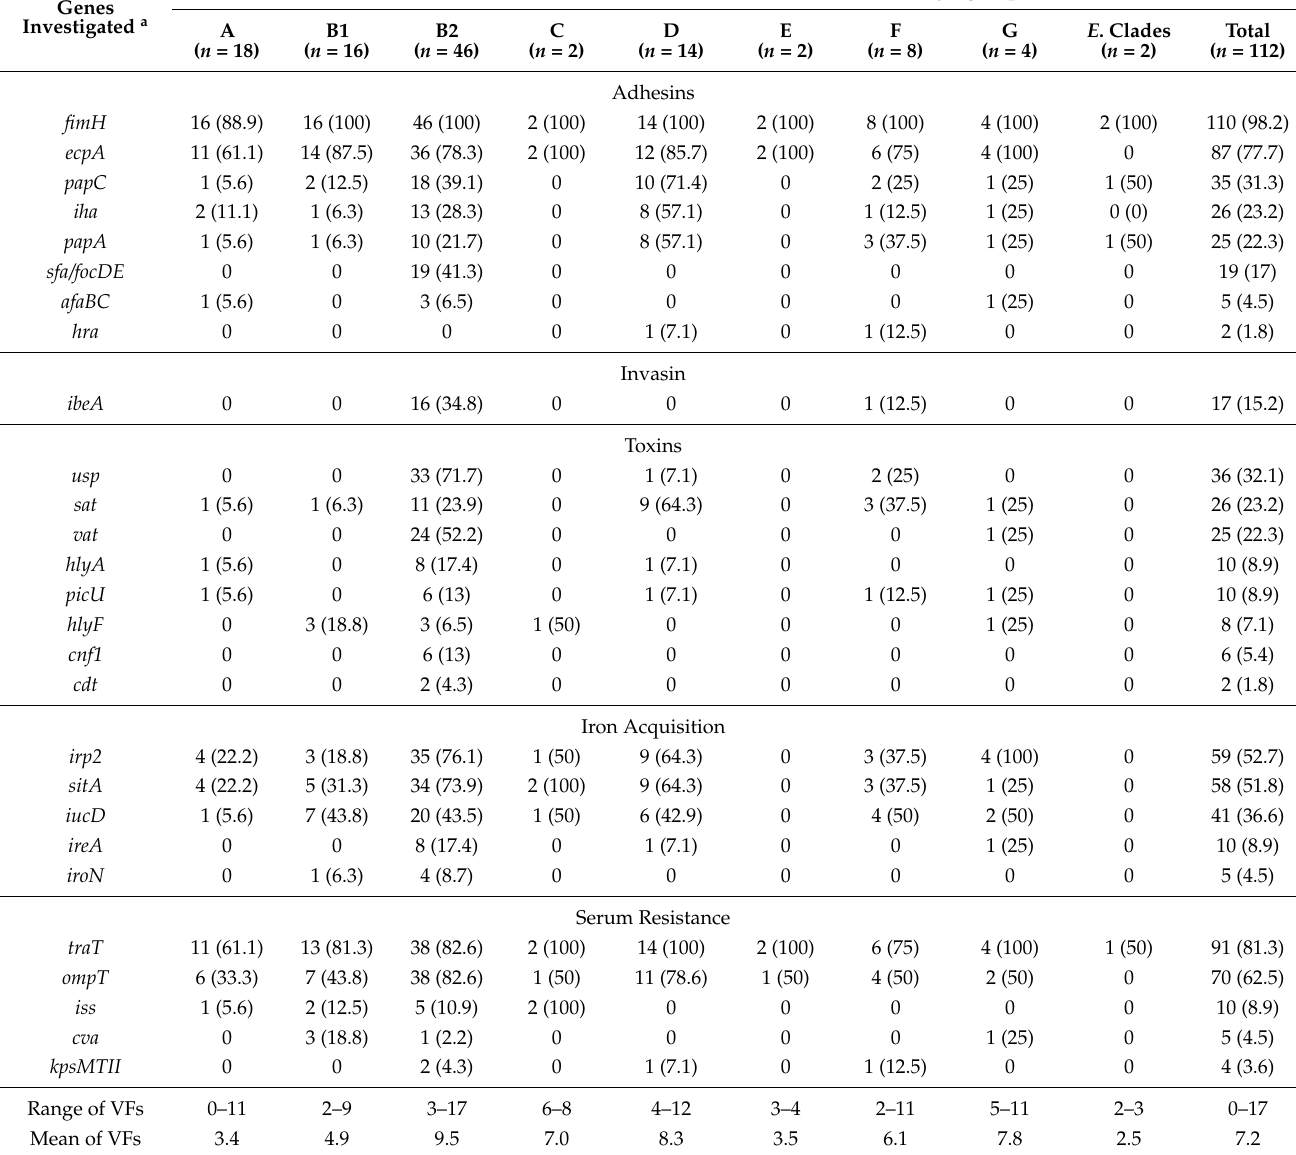
isolates (Table S5). Considering the O:H serotypes, O6:H1 and O25:H4 were the most frequent and equally detected in 7.1% (8/112) of the UPEC isolates studied (Table S5). We observed that a large number of isolates were assigned into the E. coli phylogroup B2 (41.07%, 46/112), followed by isolates assigned in the phylogroups A (16.07%, 18/112), B1 (14.29%, 16/112), D (12.5%, 14/112), F (7.14%, 8/112), and G (3.57%, 4/112). Less commonly, we observed UPEC isolates assigned into the phylogroups C, E and E . clades, with a frequency of 1.79% (2/112) in each of the phylogroups (Table 1). Table 1. Occurrence of virulence factor-encoding genes in 112 uropathogenic E. coli (UPEC) isolates identified in the distinct E. coli